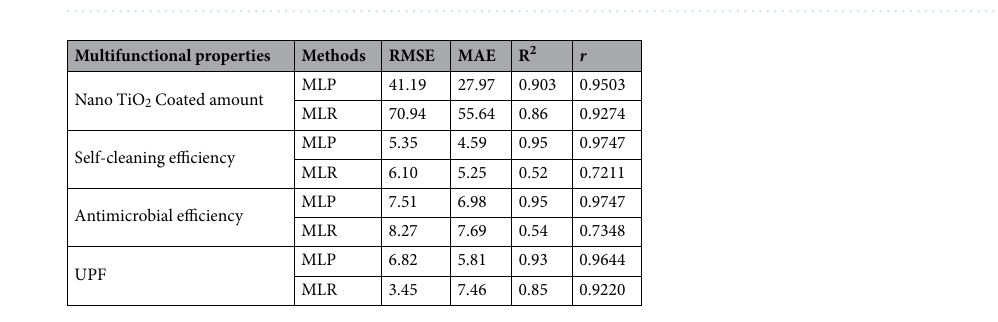
Figure 5. Absolute errors between predicted and actual values using MLP and MLR.